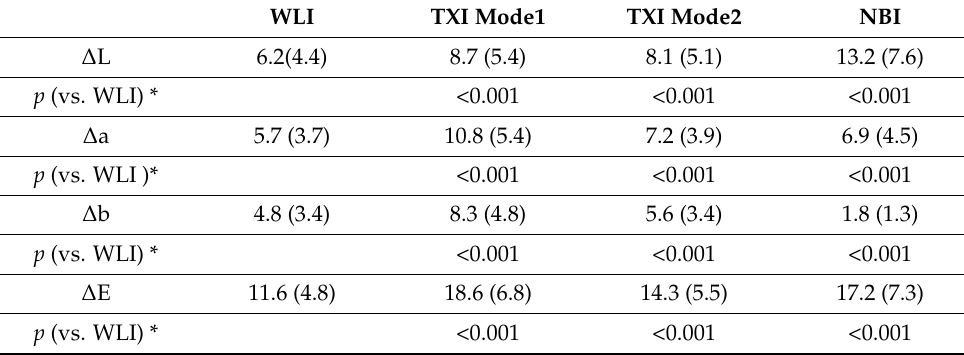
Table 2. The mean ∆ E of WLI, TXI mode1, TXI mode2, and NBI.